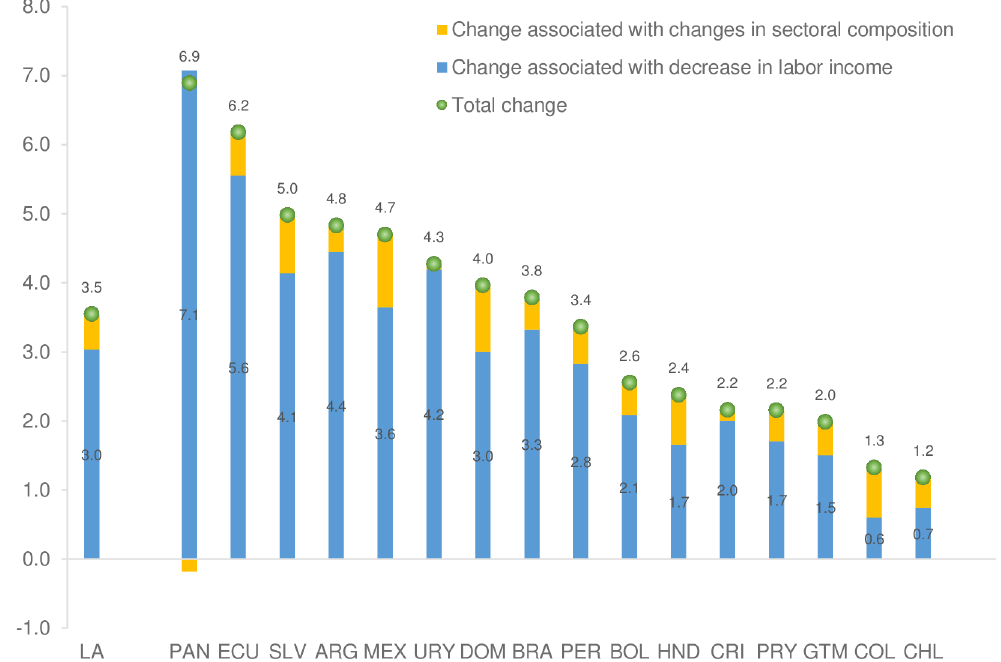
Fig 6. Latin America: Simulation of changes in the informality rate associated with changes in labor income and in the sectoral composition of the employed population (percentage points). Source: Estimates from household or employment surveys: Argentina—EPH (2019), Bolivia—ECH (2018), Brazil—PNADC (2018), Chile—CASEN (2017), Colombia—GEIH (2018), Costa Rica—ENAHO (2018), Ecuador—ENEMDU (2018), El Salvador—EHPM (2019), Guatemala—ENEI (2018), Honduras—EPHPM—(2018), Mexico—ENIGH (2018), Panama—EPM (2017), Paraguay—EPHC (2018), Peru—ENAHO (2018), Dominican Republic ENCFT (2017), Uruguay—ECH (2019). The EPH survey in Argentina only has urban